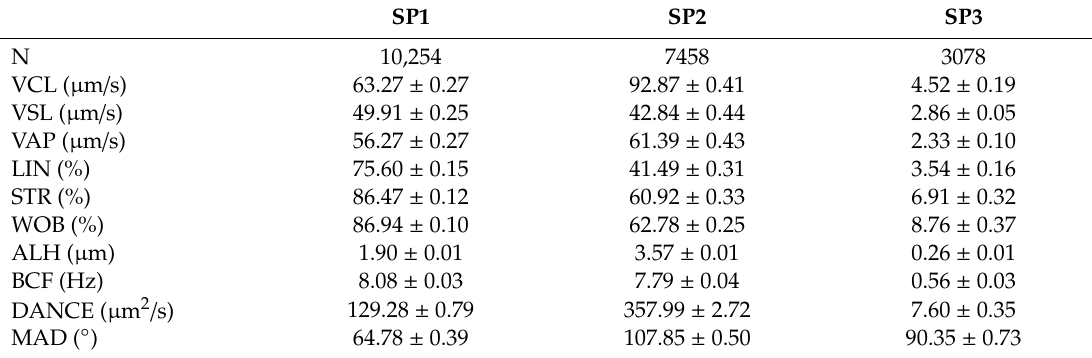
Table 2. Descriptive statistics (mean ± SEM for seven experiments) of the three motile sperm subpopulations identified in this study.